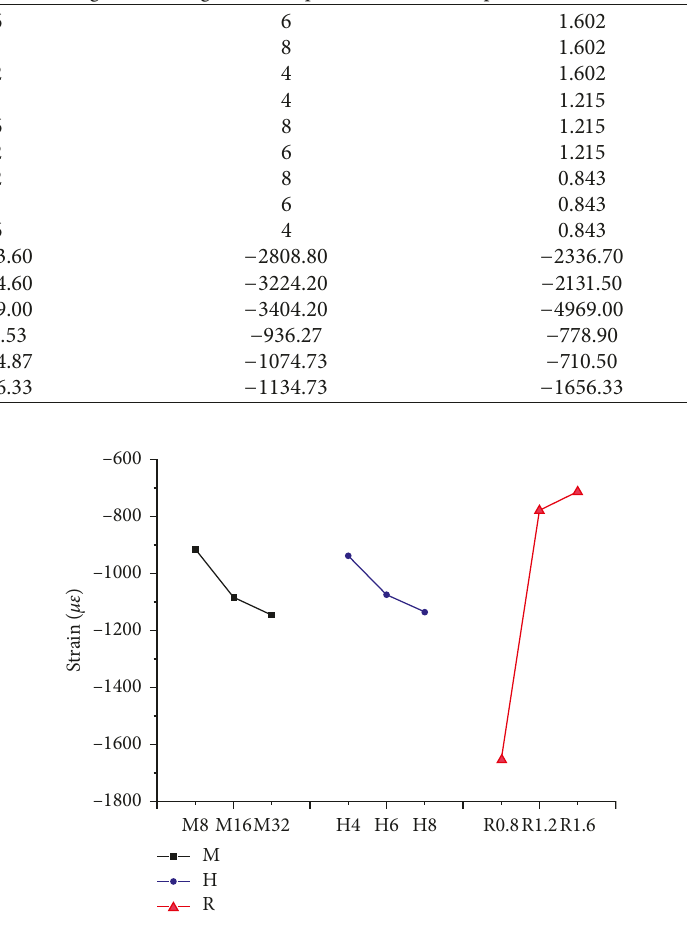
Figure 5: Slope diagram of strain influence factors. Table 5: Variance analysis table.